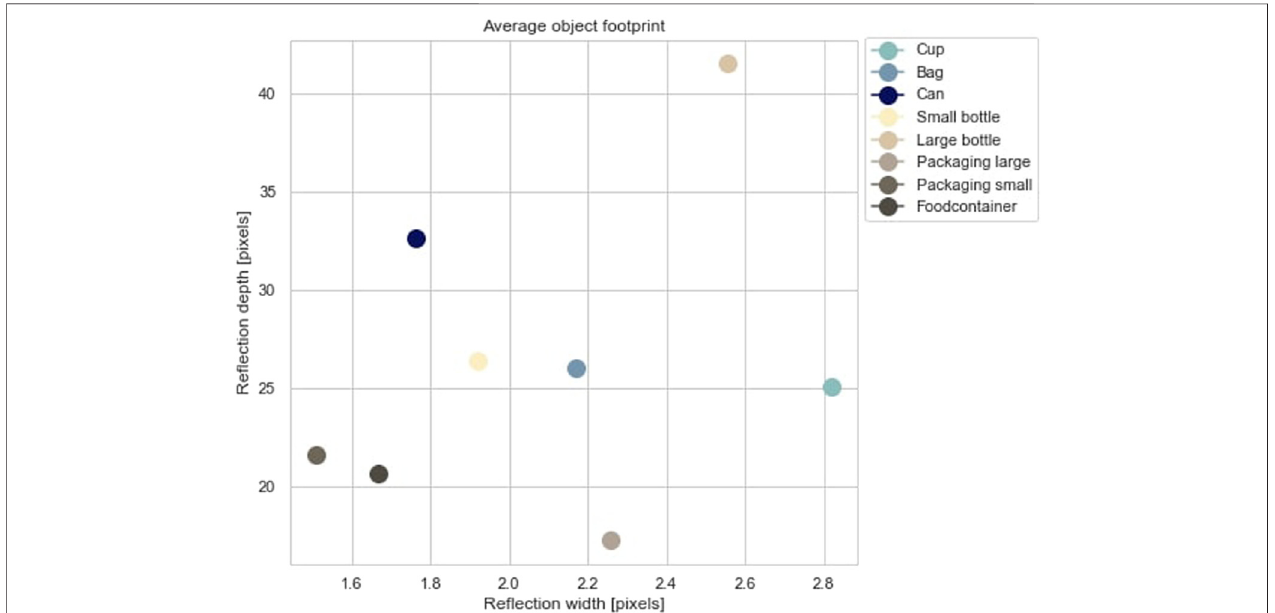
FIGURE 6 | The average sonar re fl ection footprint (depth and width) of the different items tested.